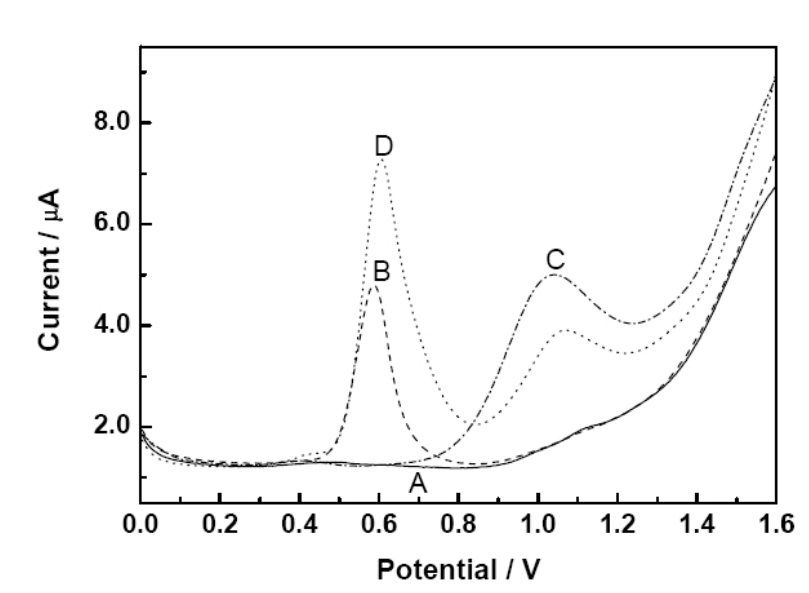
Fig. 4 DPVs obtained on BDD electrode in 0.1 M HclO 4 solution(A), A+ 1 × 10 − 4 M DA (B), A+1 . 0 × 10 − 3 M AA (C), and A+ 1 × 10 − 4 M DA +1 . 0 × 10 − 3 M AA (D) (The increment E: 0.004 V; Amplitude: 0.05 V; Pulse width: 0.05 s; Pulse period: 0.2